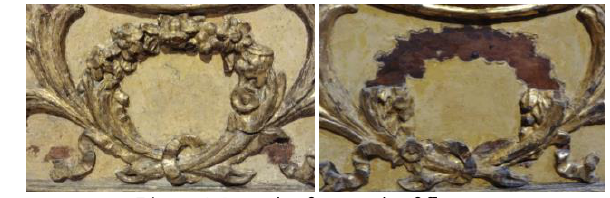
Figure 4. Branch of a wreath of flowers.